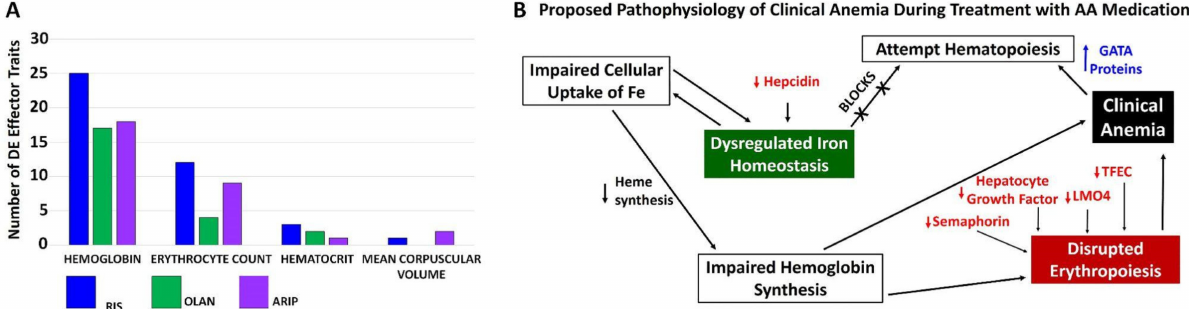
Figure 4. Differentially Expressed Traits In Vivo and Development of Clinical Anemia. Total numbers of DE traits associated with clinical measures of anemia (hemoglobin, hematocrit, erythrocyte count and mean corpuscular volume) in mice treated with RIS (panel ( A ), blue bars), mice treated with OLAN (panel ( A ), green bars) and patients treated with ARIP (panel ( A ), purple bars) are shown. The directional change of multiple DE traits led to the development of a proposed mechanism for the development of clinical anemia following AA exposure ( B